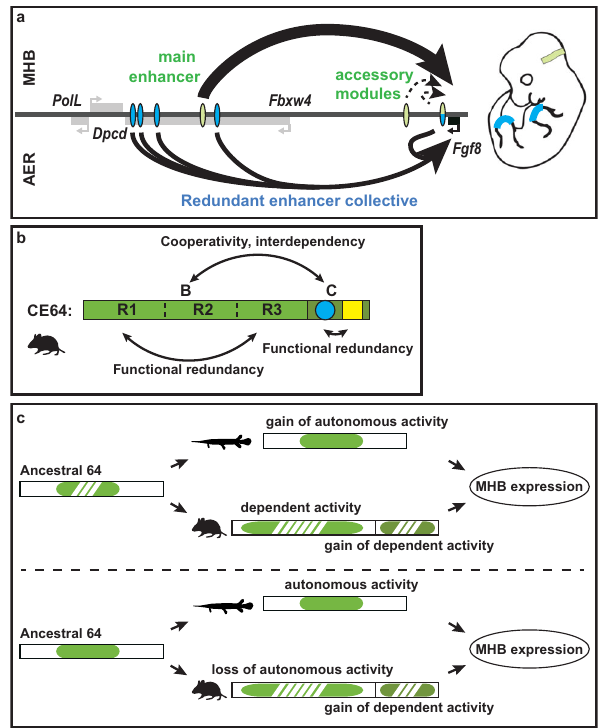
Fig. 7 Two modes of regulatory redundancy provide robustness to Fgf8 gene expression. a Schematic representation of enhancer activity in the MHB and the AER. In the MHB, one main enhancer is required and suf fi cient to direct Fgf8 expression (upper panel). In the limb AER, a collective of redundant enhancers, each by themselves dispensable, directs gene expression (lower panel). Blue ovals: AER enhancers, green ovals: MHB enhancers. b Schematic of the mouse CE64 and its subunits. CE64 is composed of two essential regulatory units that are reciprocally dependent and cannot alone direct expression in the MHB. Both of the regulatory subunits exert functional redundancy within themselves. This redundancy may be encoded by similar TFBS or recurrent DNA motifs in 64-B, while in 64-C it is encoded by two distinct DNA signatures (blue circle, yellow square) that reciprocally can buffer the loss of each other. R1 to R3 indicates redundant blocks within 64B. c Two scenarios for CE64 evolution. Upper panel: both spotted gar and the tetrapod lineage independently gained MHB regulatory activity, spotted gar within the ancestral enhancer (64-B in mouse) and tetrapods by addition of a new subunit (64-C). Lower panel: spotted gar CE64 retain an autonomous MHB regulatory activity in the absence of 64-C while in the tetrapod lineage, 64-B appears to have lost its autonomous activity and 64-C has been added to the regulatory wiring. Green area represents autonomous regulatory activity and dashed green non-autonomous